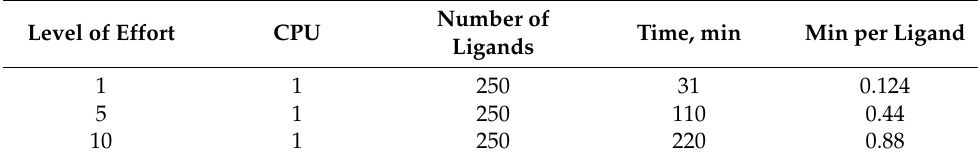
Table 1. Measurement results of computing capabilities 1 .